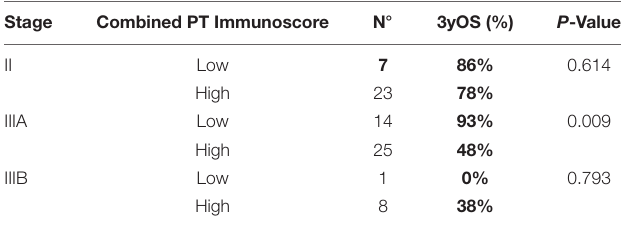
TABLE 3 | Three-year survival of stage II, IIIA, and IIIB non-small-cell lung cancer (NSCLC) patients according to high or low combined peritumoral (PT) immunoscore.